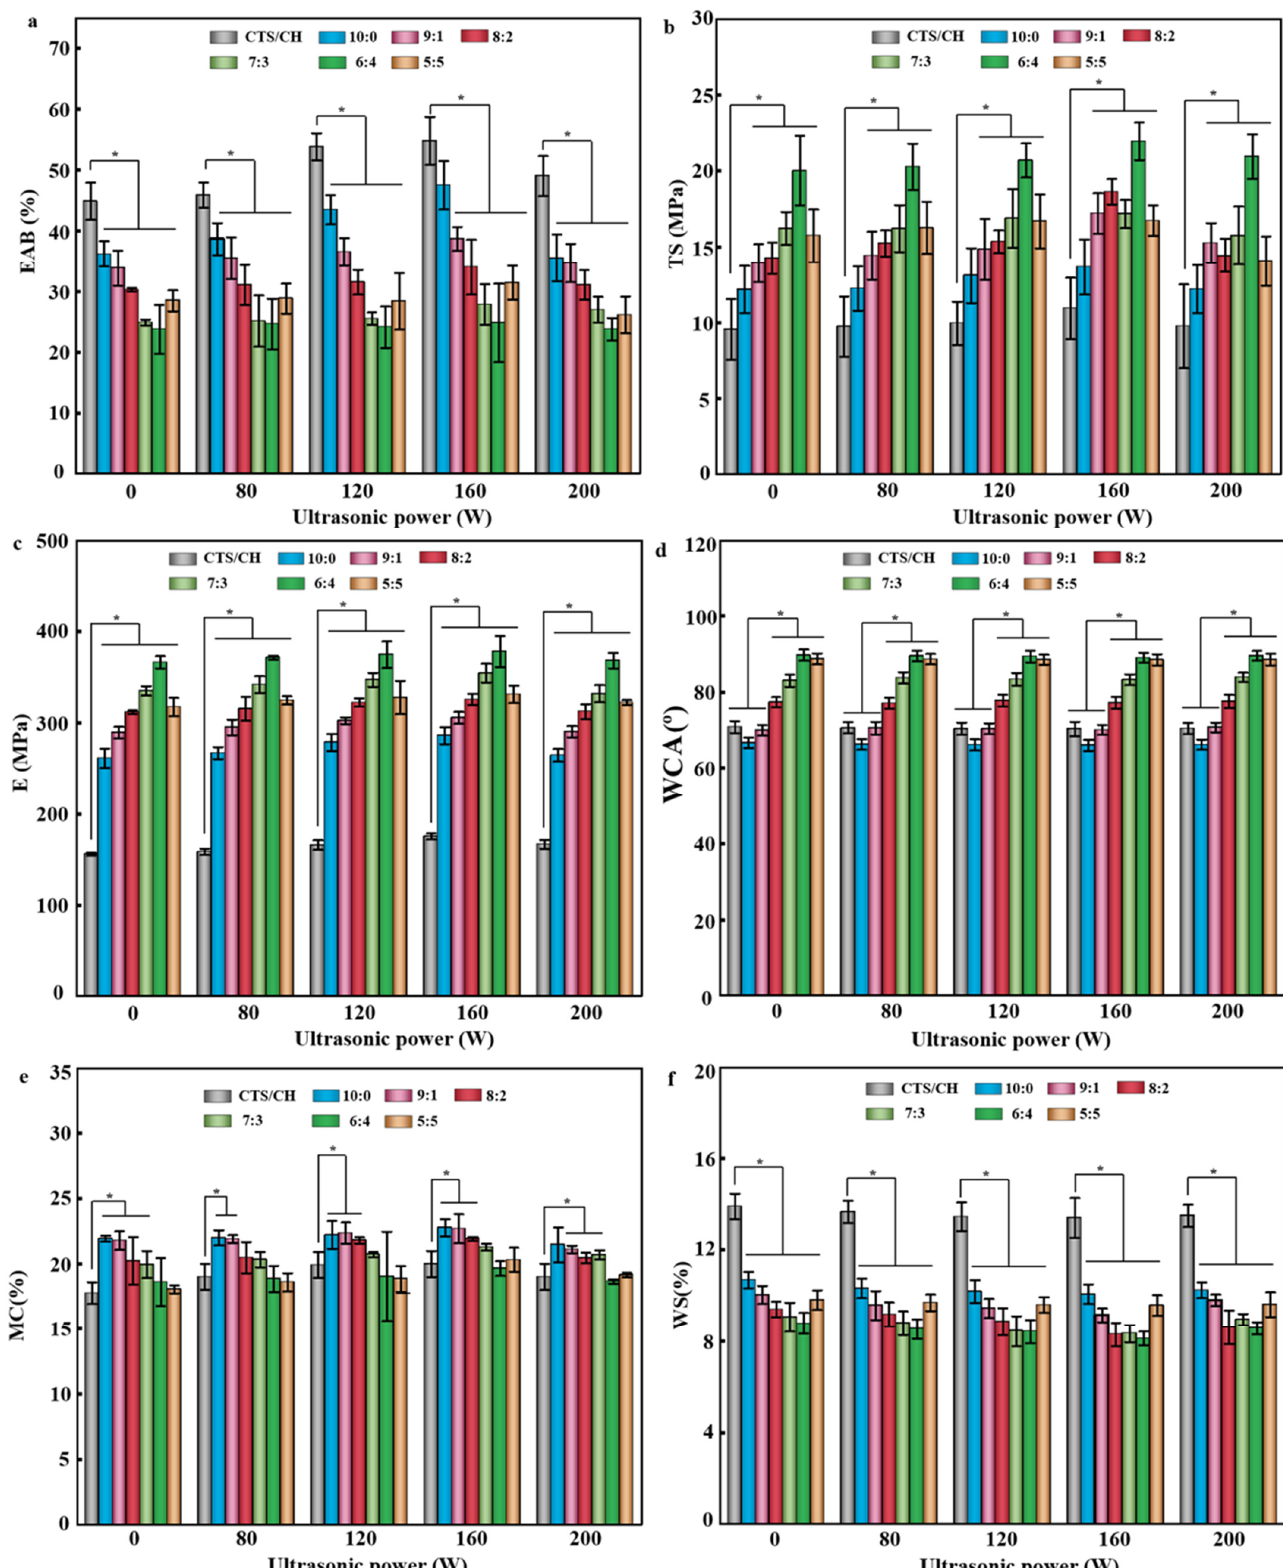
Figure 5. ( a ) EAB, ( b ) TS, ( c ) E, ( d ) WCA, ( e ) MC ( f ) WS values of the CTS/CSH, CTS/CSH/TiO 2 , and CTS/CSH/TiO 2 /Gr composite films fabricated at various ultrasonication powers (* p < 0.05, n = 7 ).